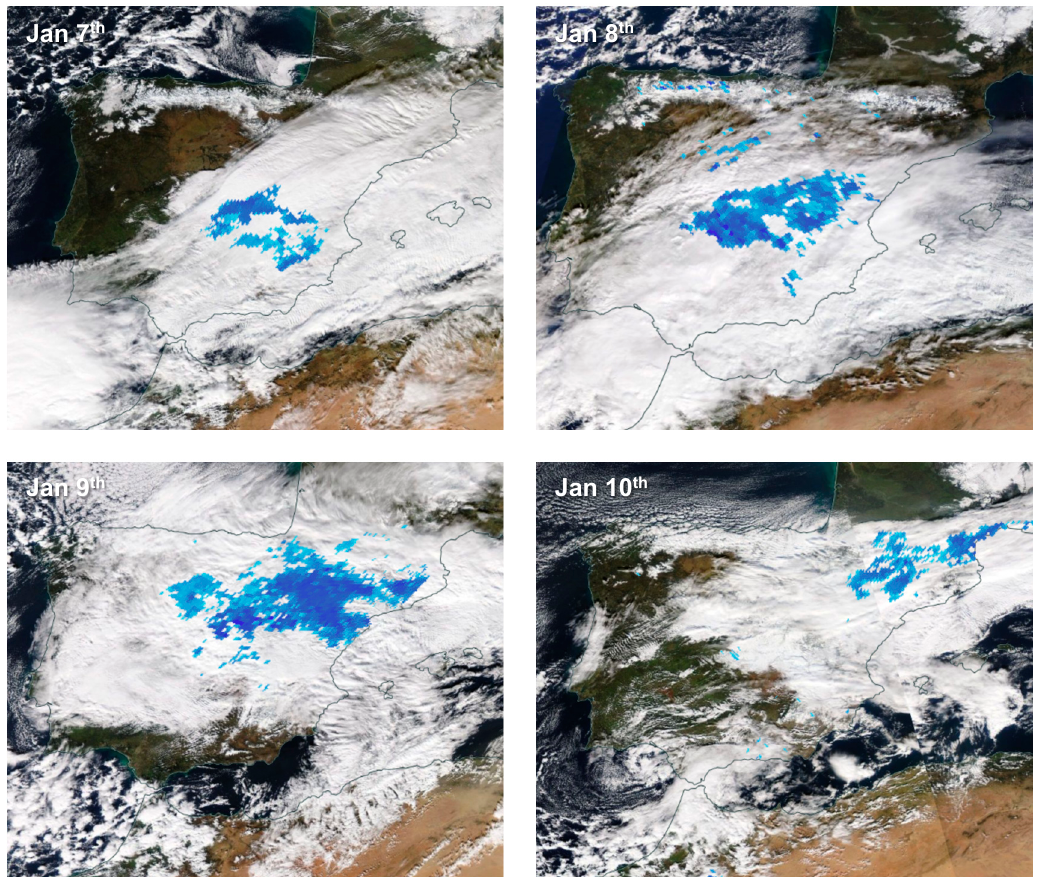
Figure 2. Terra/MODIS (1/4/3, ‘true color’ combination) imagery with GPM (GMI) snow detection (blues) for the 7th to the 10th of January 2021. The GPM product is the 2AGPROFGMI (‘Level 2A Goddard Profiling algorithm’ or ‘GPM_2AGPROFGPMGMI’). 2AGPROFGMI has a daily resolution. Areas in blue are those where the 2AGPROFGMI has detected snow.